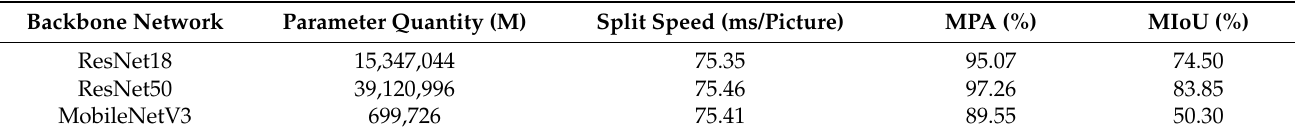
Table 5. DeepLabV3+ with different backbone networks.